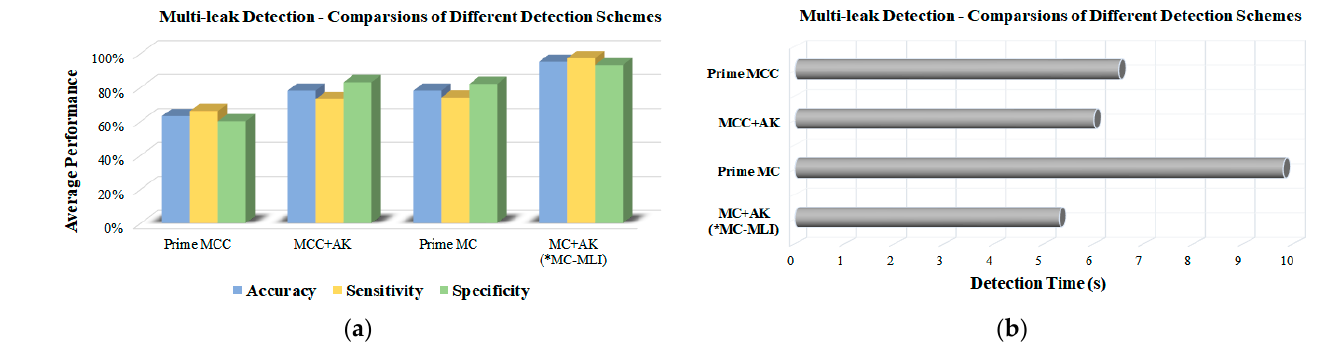
Figure 4. Performance evaluation of the proposed MC-MLI. ( a ) Comparisons of average accuracy, sensitivity, and specificity; ( b ) Comparisons of average detection time. * Note: MC + AK is actually the proposed MC-MLI scheme.